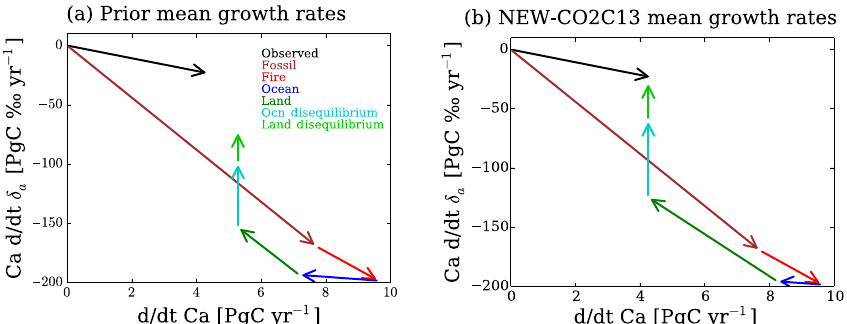
Figure 5. Annual mean carbon ( x axis) and δ 13 C ( y axis) growth rates for (a) the prior estimates and for (b) the NEW − CO2C13 experiment. Colored arrows represent the different sources and sinks of the carbon cycle. A closed budget for both tracers was accomplished in the NEW − CO2C13 experiment, as indicated by the resultant vector (sum of all colored arrows) returning to the black arrow (observed growth rate in atmosphere). To close the long-term trend we increased the isodisequilibrium fluxes by 20%.